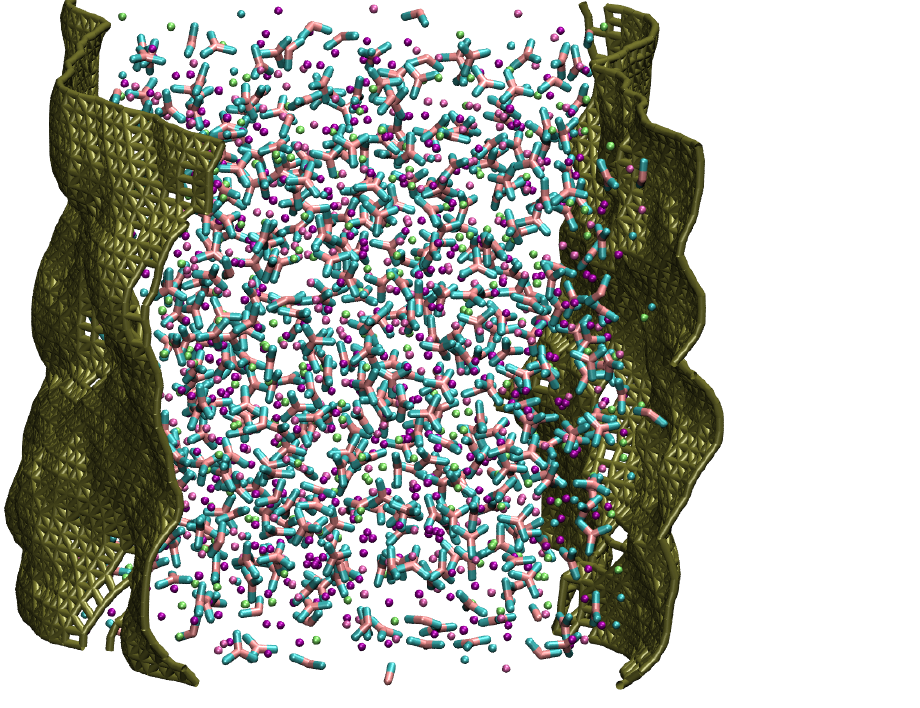
Figure 5 A representative snapshot of the LiKCO 3 system with the corresponding instantaneous in- terface. The atoms comprising the salt are depicted in green, purple, blue, and pink and the instantaneous interface is shown in gold. Full-size DOI: